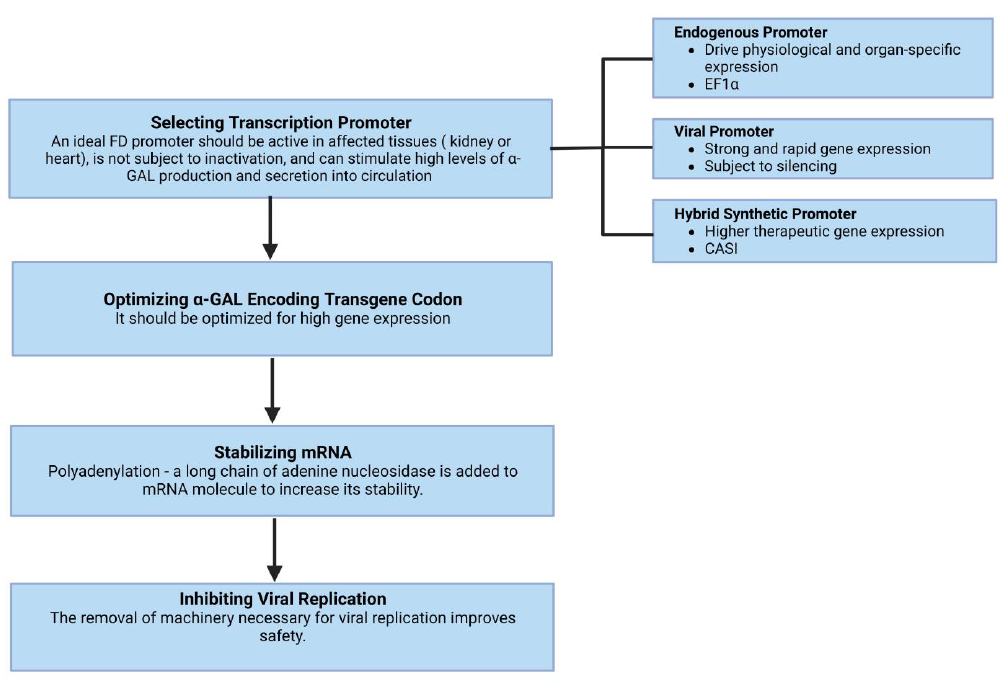
Figure 2. The basic requisites of effective gene therapy include a transcription promoter that is active in affected tissues and optimized for high gene expression. Other essential components include the stabilization of mRNA and inhibiting viral replication.